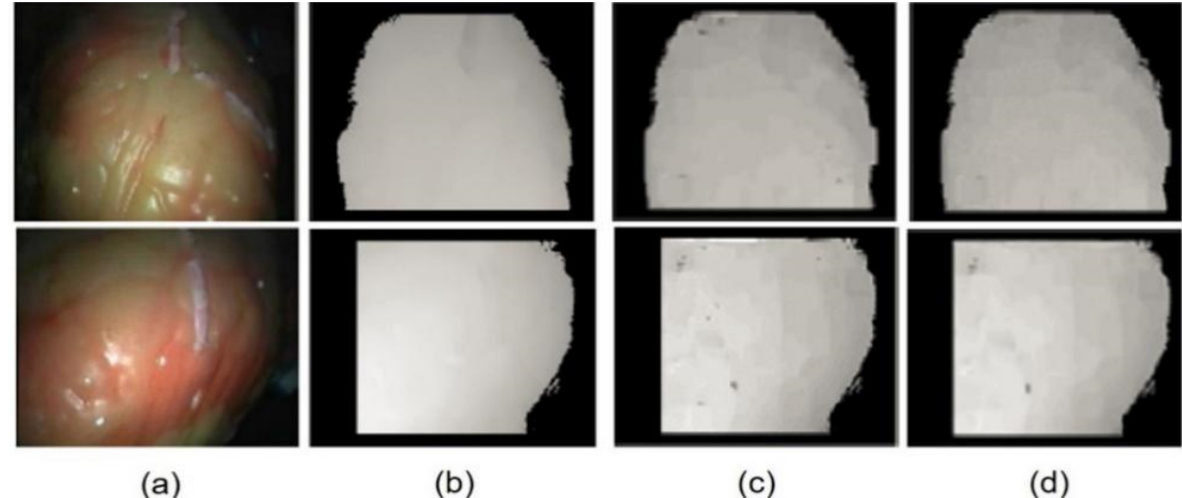
Figure 6. Two adaptive weight methods correspond to the matching results. ( a ) Left map of heart